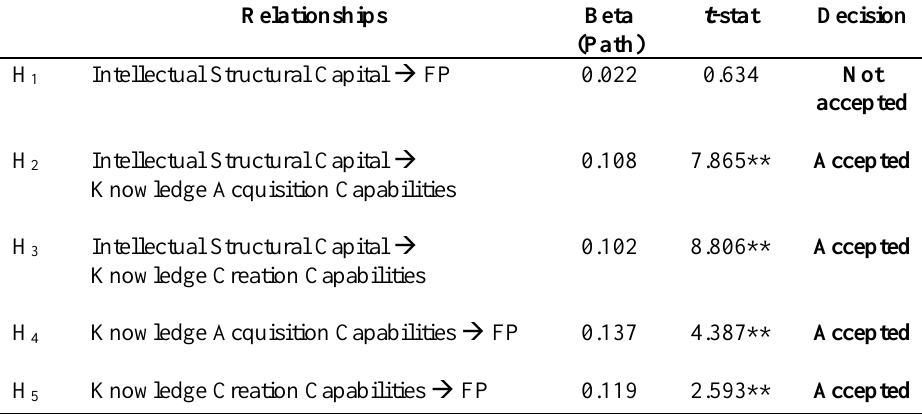
Table 7: Path Coefficients between Constructs and their Significance Relationships Beta t -stat (Path)